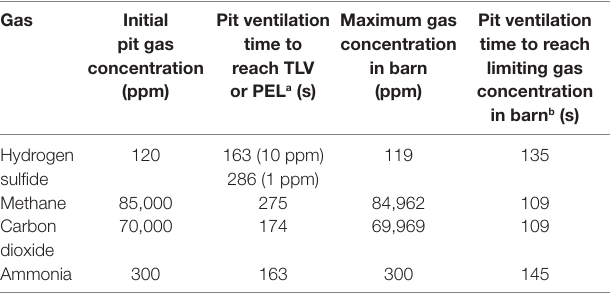
TABle 1 | case 1 simulation results for hydrogen sulfide, methane, carbon dioxide, and ammonia: slotted-covered manure pit beneath tunnel-ventilated barn – parallel flow.